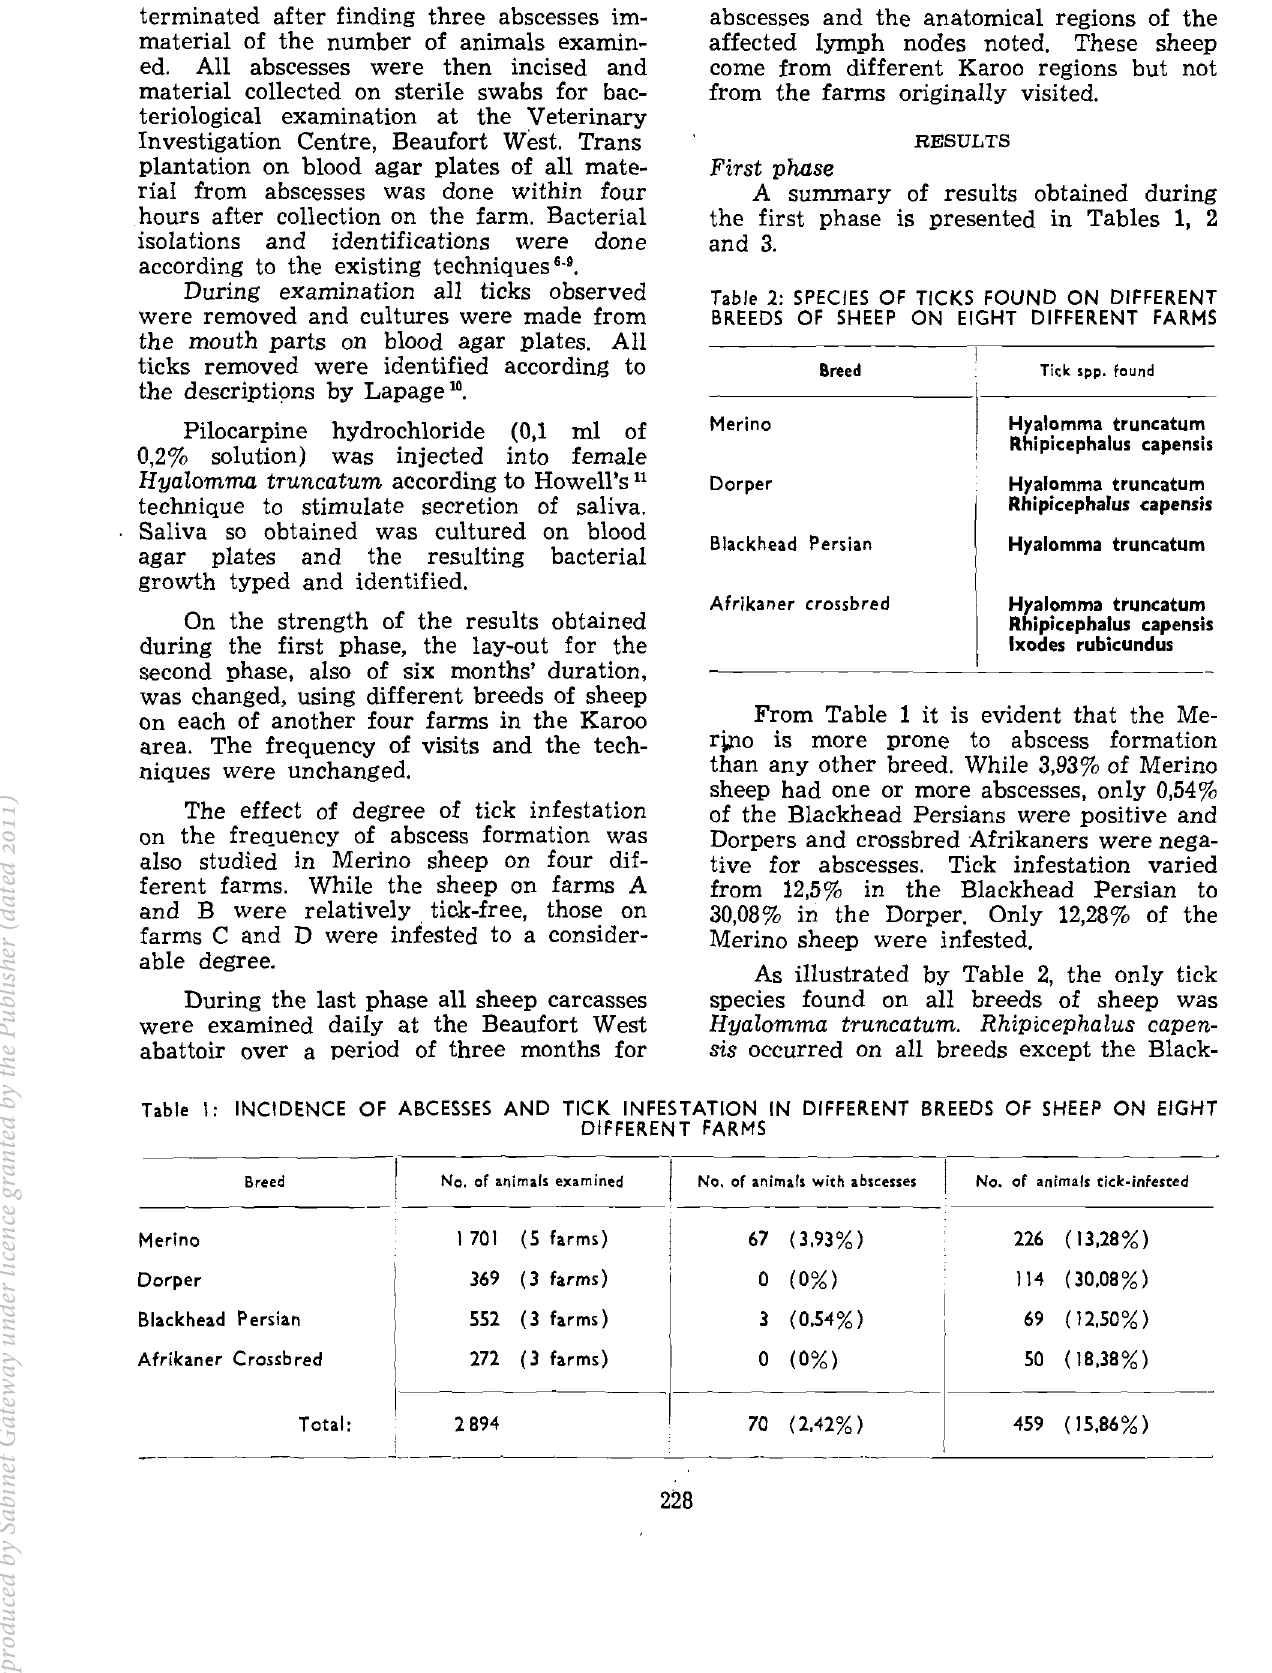
Table 2: SPECIES OF TICKS FOUND ON DIFFERENT BREEDS OF SHEEP ON EIGHT DIFFERENT FARMS